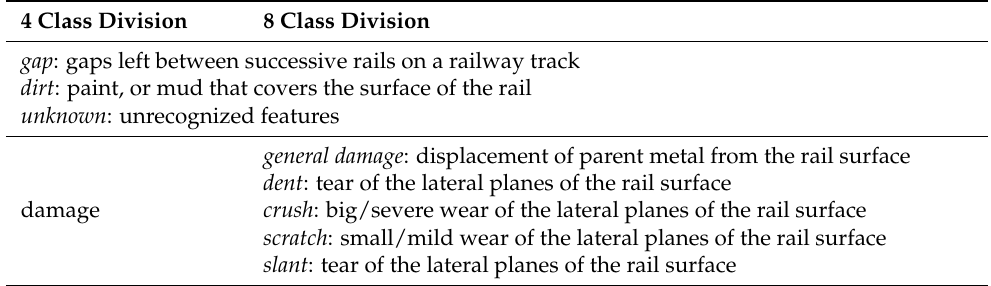
Table 1. Two divisions of the rail defect